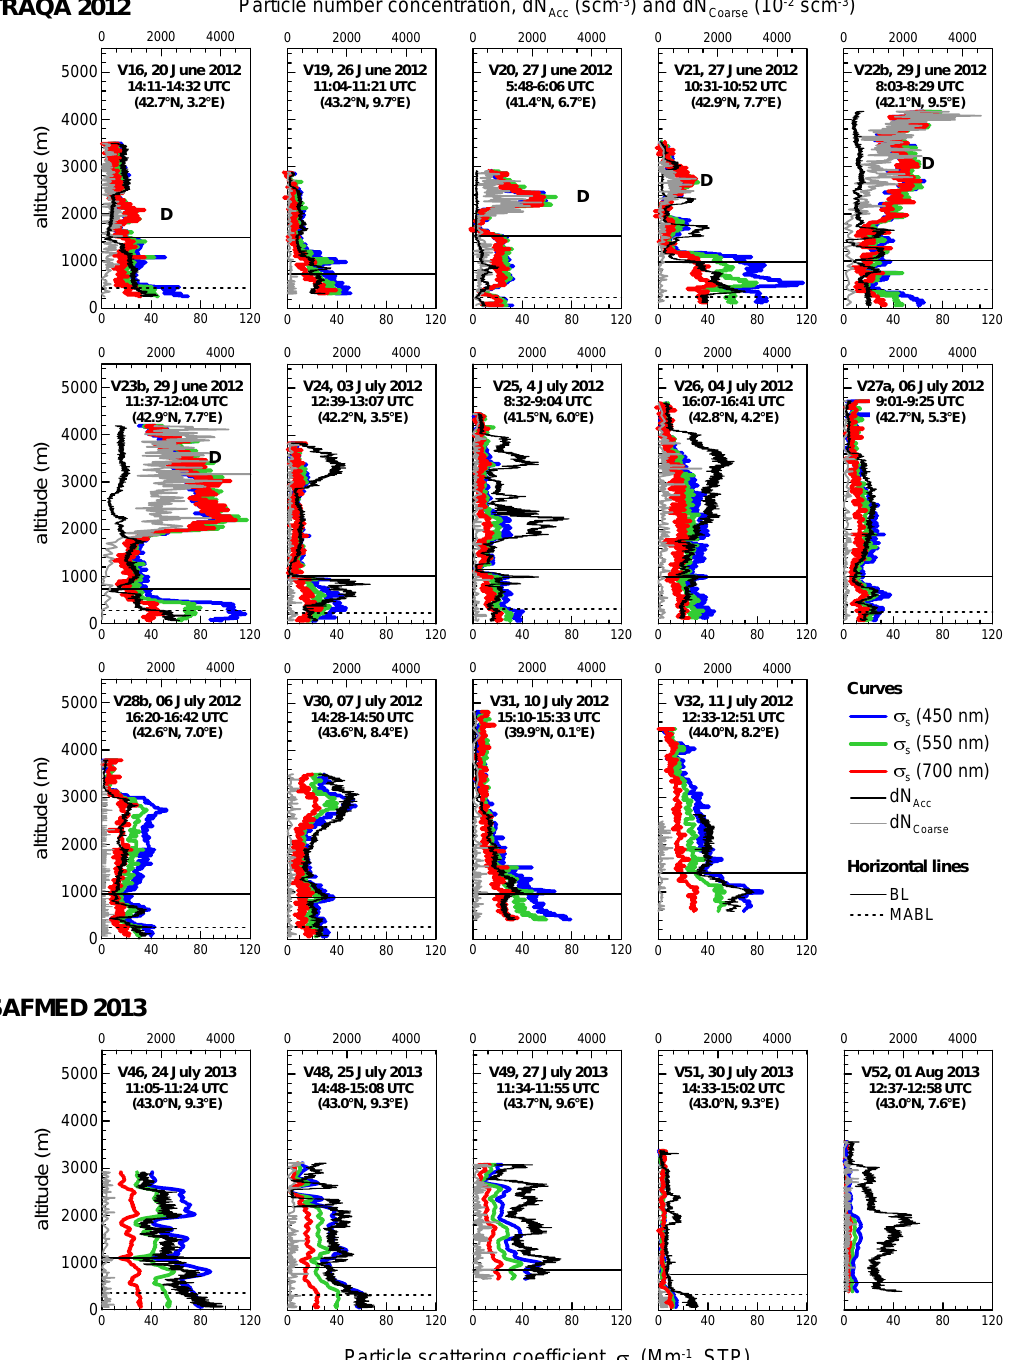
Figure 6. Vertical profiles of the spectral scattering coefficient σ s at 450, 550, and 700nm and particle number concentration in the 0.1– ) diameter ranges observed during TRAQA and SAFMED. Data are reported at STP (standard 1.0µm (d N Acc ) and 1.0–4.0µm (d N ∗ Coarse temperature and pressure, T = 293.15K and P = 1013.25hPa). The heights of the top of the marine aerosol boundary layer (MABL) and planetary boundary layer (BL) estimated from the meteorological profiles are also indicated in the plots. The label D is used to identify the aerosol layers affected by Saharan dust. For certain flights (V22, V23, V27, and V28) two vertical soundings were performed; the letters “a” and “b” after the flight number in this plot distinguish between data taken from the first and the second sounding, respectively. ( ∗ data for d N Coarse are multiplied by 100 in the